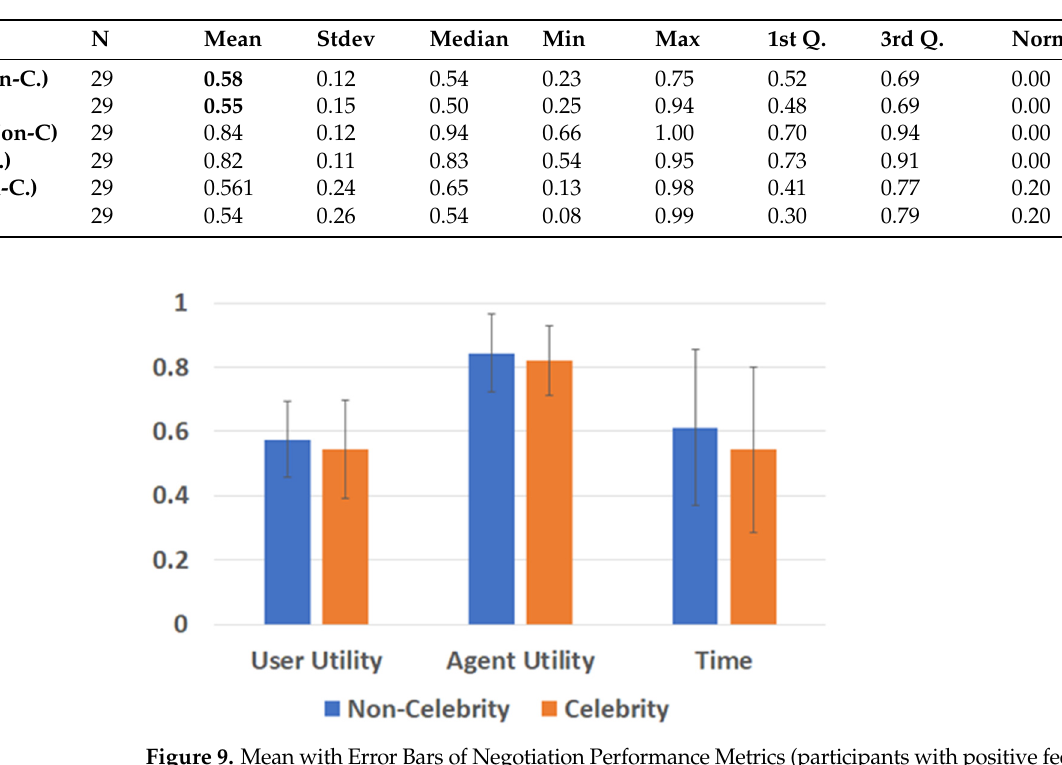
Table 3. Statistics for only Successful Negotiation Sessions (participants with positive feelings).